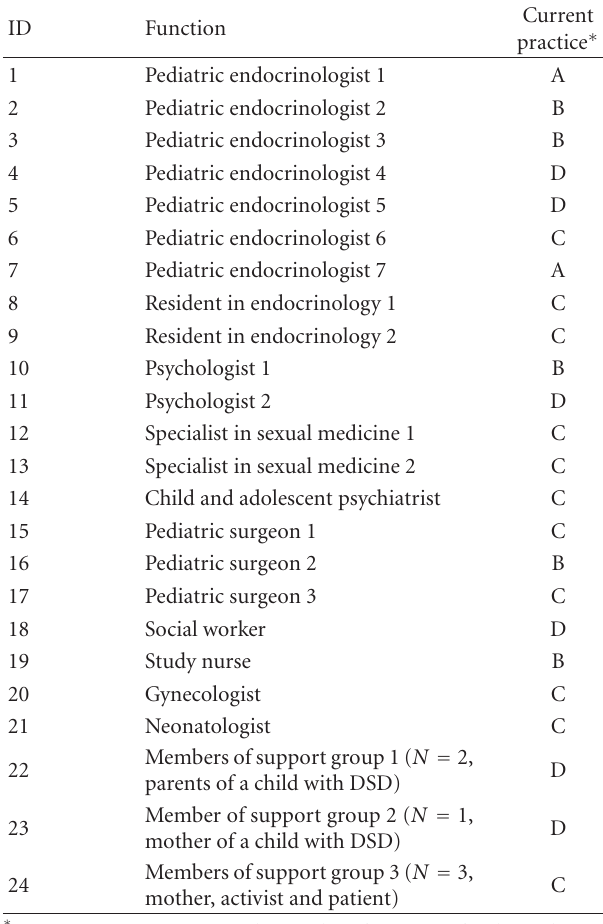
Table 1: Participants and their